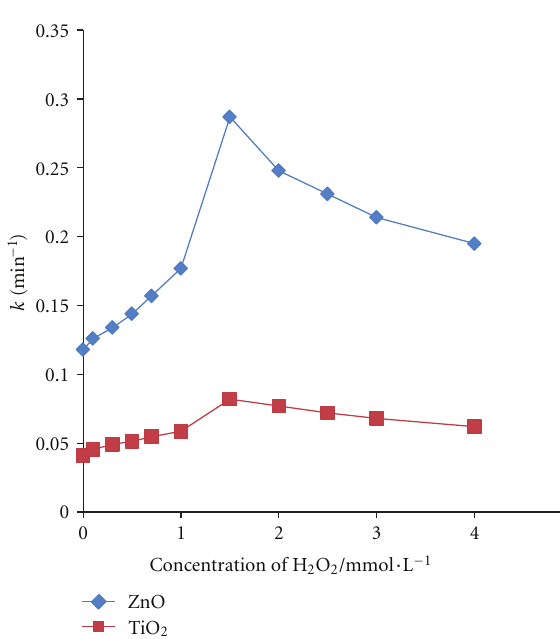
Figure 9: E ff ect of addition of H 2 O 2 on rate constant.